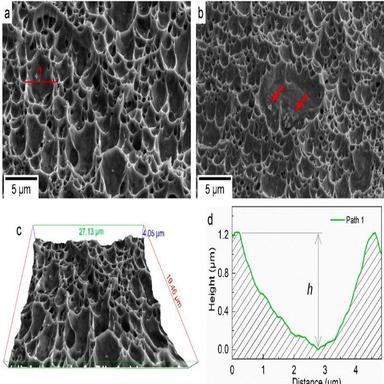
(a) and (b) Typical SEM images of fracture surface for 95 J impacted specimen. MnS inclusions are marked with red arrows in (b). (c) Corresponding 3D view of (a) after DEM reconstruction. (d) Fracture surface profile along the red line drawn in (a) and the measurement of dimple depth (h).